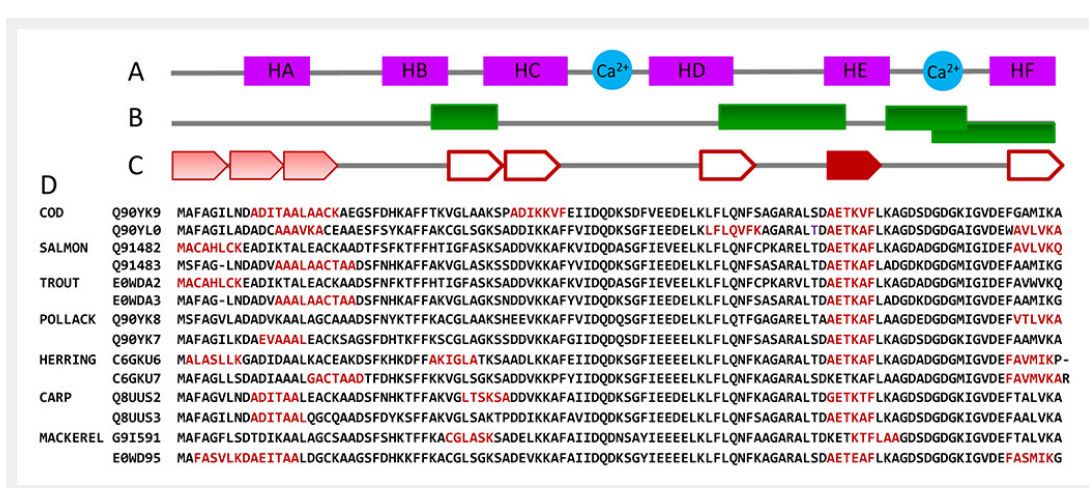
Propensity of fish β-parvalbumin sequences to form amyloids. ( A ) Fish β-parvalbumin fold described for cod (PDB ID:2MBX), carp (PDB ID: 4CPV), hake (PDB ID: 1BU3), pike (PDB ID: 1PVB) and whiting (PDB ID: 1A75) chains is largely conserved and consists of six α-helices pairing as AB, CD and EF and forming three EF-hand motifs, two of which (CD and EF) coordinate Ca 2+ . ( B ) Immunological reactive sites described for fish β-parvalbumins, shown as green rectangles, embrace the spacers between motifs and on the C-terminal motif [29–31]. ( C ) Some hexapeptides with adhesive properties found in β-parvalbumin sequences from commercially valuable fish and known allergic potential using Zipper Db flank the immunological reactive sites. Hexapeptides (single or extended) are depicted in red, by ( C ) arrows (the saturation of the colour is proportional to the similarity of the segments) and by ( D ) their